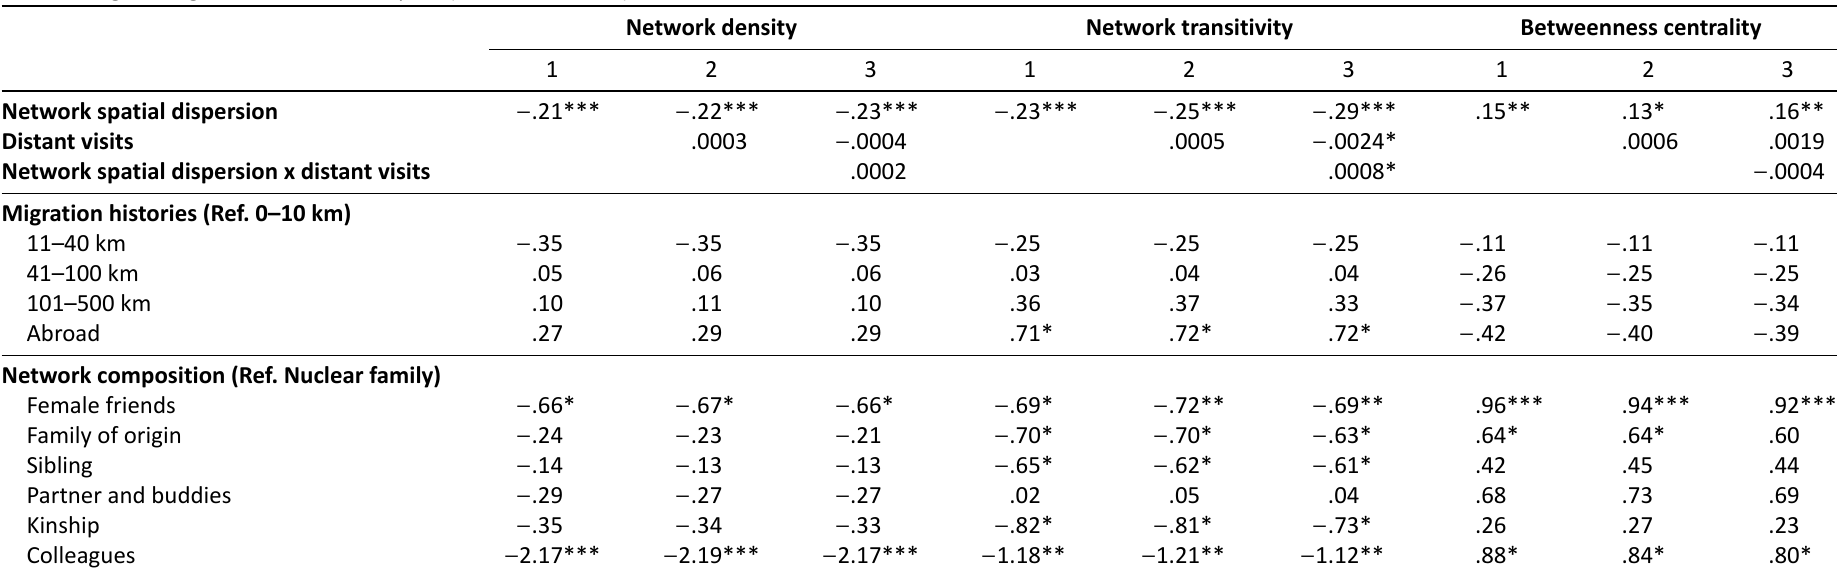
Table 3. Logistic regressions of social capital (beta